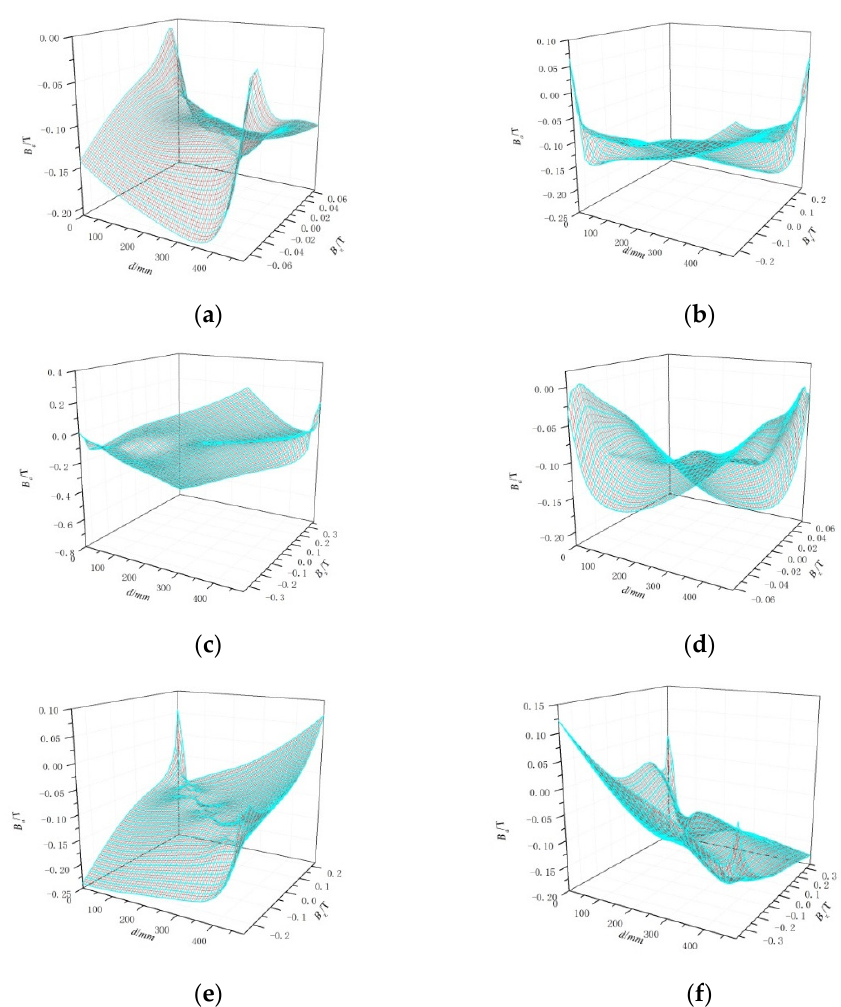
Figure 13. Radial and axial magnetic leakage curve: ( a ) measurement position A; ( b ) measurement position B; ( c ) measurement position C; ( d ) measurement position D; ( e ) measurement position E; ( f ) measurement position F.